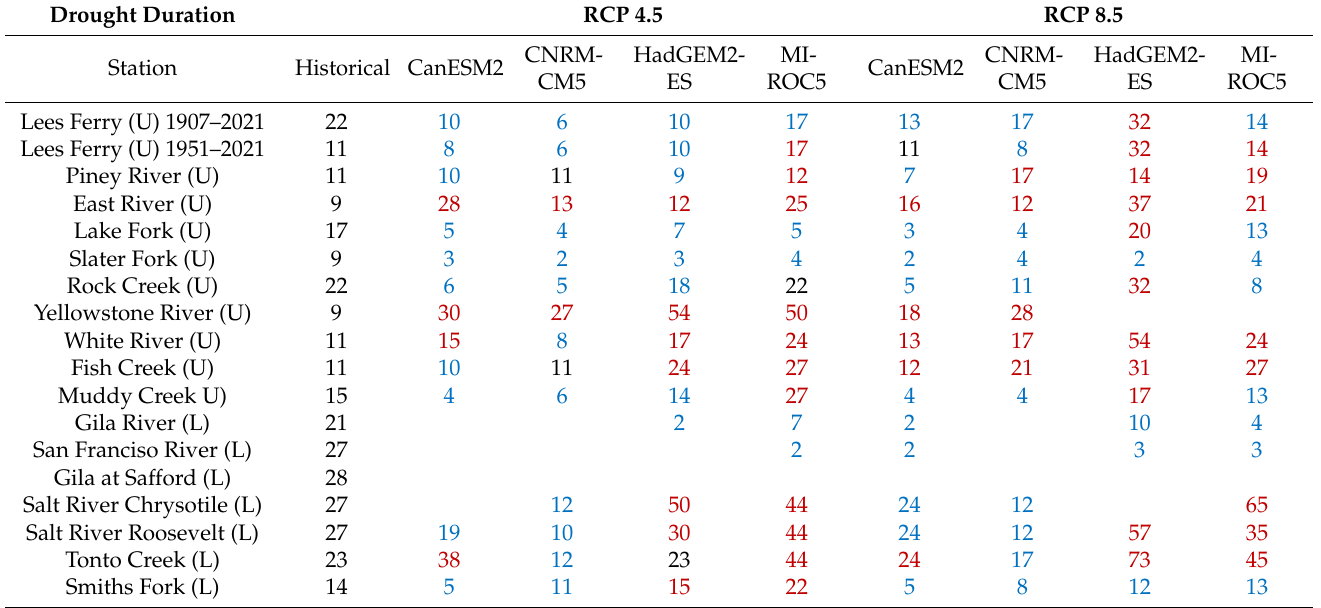
Table 2. Duration (in years) of drought and surplus for Upper (U) and Lower (L) Basin stations based on 1951–2021 for all stations and also the time period 1907–2021 for Lees Ferry. For drought duration, red values are higher than the historical record and blue values are lower. For surplus duration, blue values are higher than the historical record and red values are